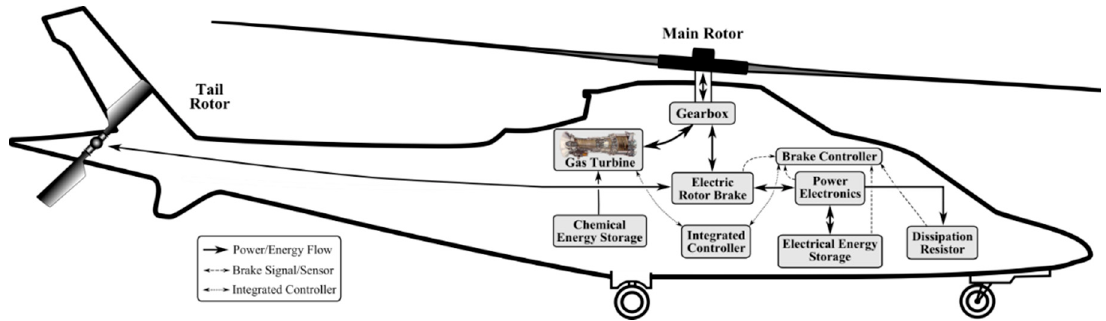
Figure 1. Systematic diagram of a theoretical more electric helicopter including an electric rotor brake.